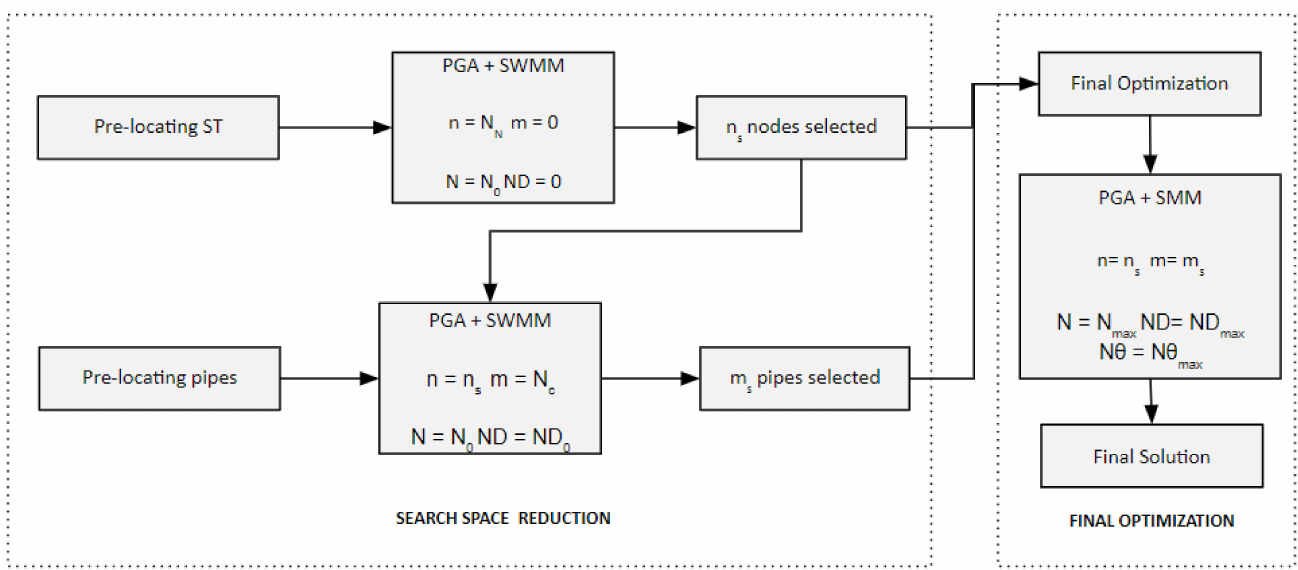
Figure 4. Optimization